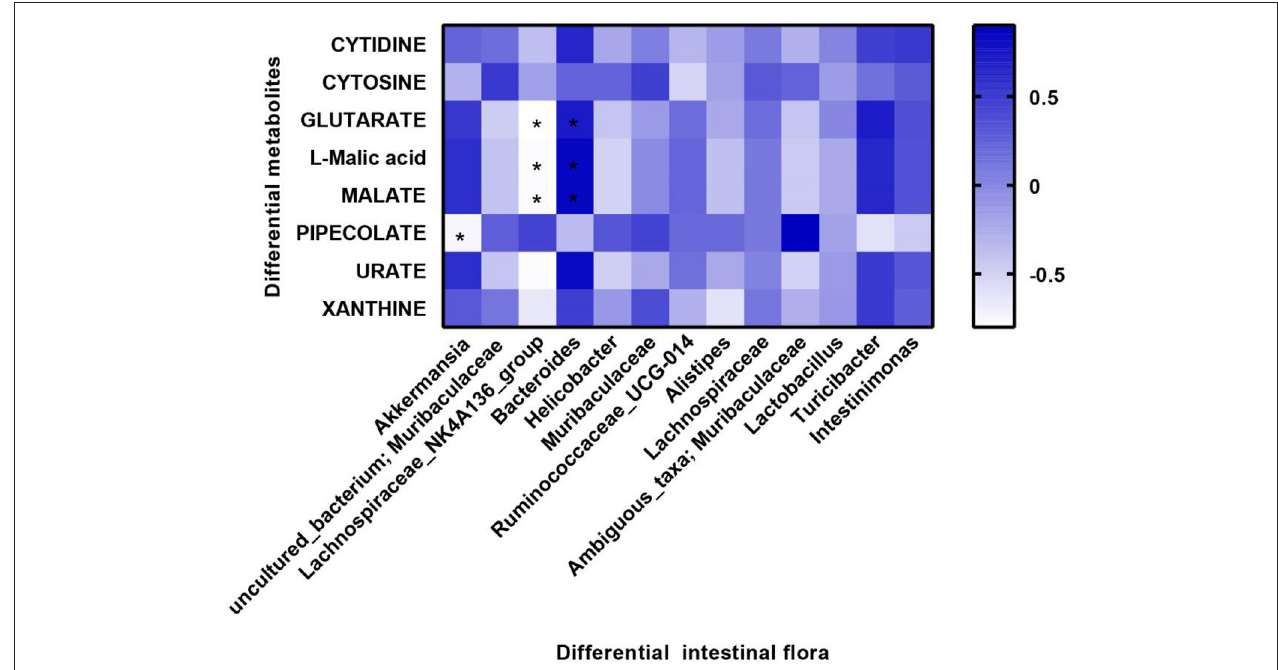
FIGURE 6 | Correlation between microbial diversity and metabolites. Differential metabolites are displayed on the y-axis, and differential flora are displayed on the x-axis. Blue color represents positive correlation, and white color represents negative correlation. Spearman analysis was used to compare all groups. * P < 0.05 differential metabolites vs. differential intestinal